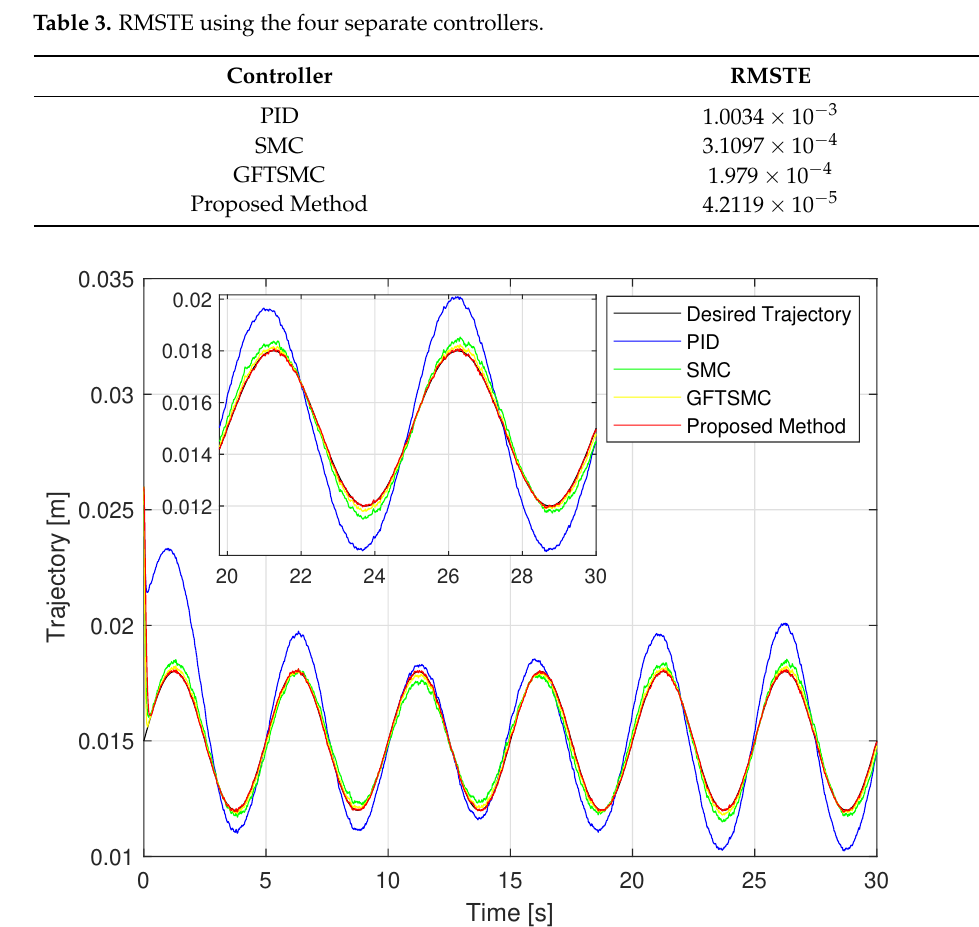
Figure 6. The controlled ball trajectory under four controllers: planned trajectory and actual trajectory.